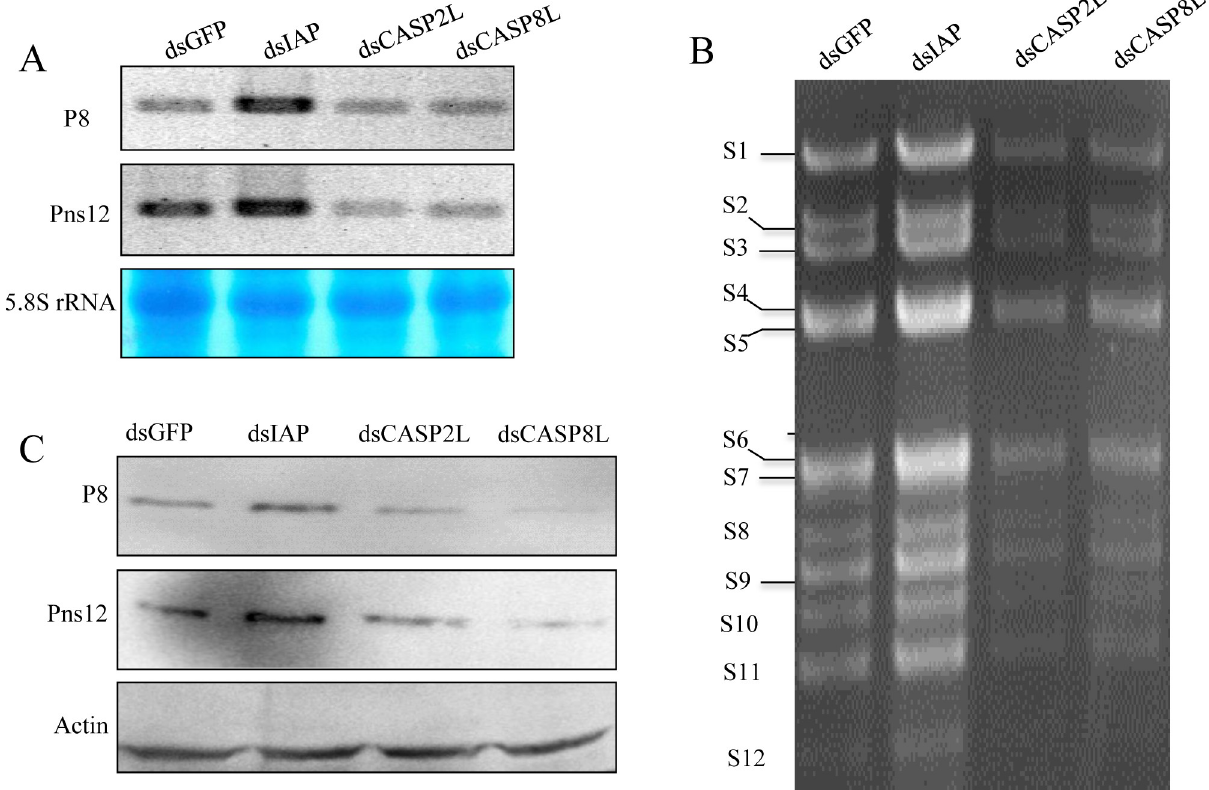
Fig 6. The apoptotic response induced by RGDV infection facilitated viral infection in continuous cultured cells of R . dorsalis . Effects of synthesized dsRNAs on the synthesis of viral mRNAs (A), the synthesis of viral genome dsRNAs (B), and the accumulation of viral proteins (C) in virus-infected cells. The dsRNA-treated cells were inoculated with purified RGDV (MOI of 0.1), then harvested at 72 hpi for northern blots, dsRNA isolation or western blots. (A) Approximately 5 μ g of total RNAs extracted from cultured cells at 72 hpi were detected with DIG-labeled probes for viral genes of major outer capsid protein P8 or viral replication protein Pns12. Lower panel: methylene blue detection of 5.8S rRNA as a control to confirm loading of equal amounts of RNA in each lane. Image is representative of multiple experiments with multiple preparations. (B) Viral genome dsRNAs from infected cultured cells was analyzed in 1.0% agarose gel electrophoresis and ethidium bromide staining. The size classes of viral dsRNA segments are indicated. (C) Viral proteins prepared from cells lysates were analyzed at 72 hpi using polyclonal antibodies against P8 or Pns12. An actin-specific antibody was used for the